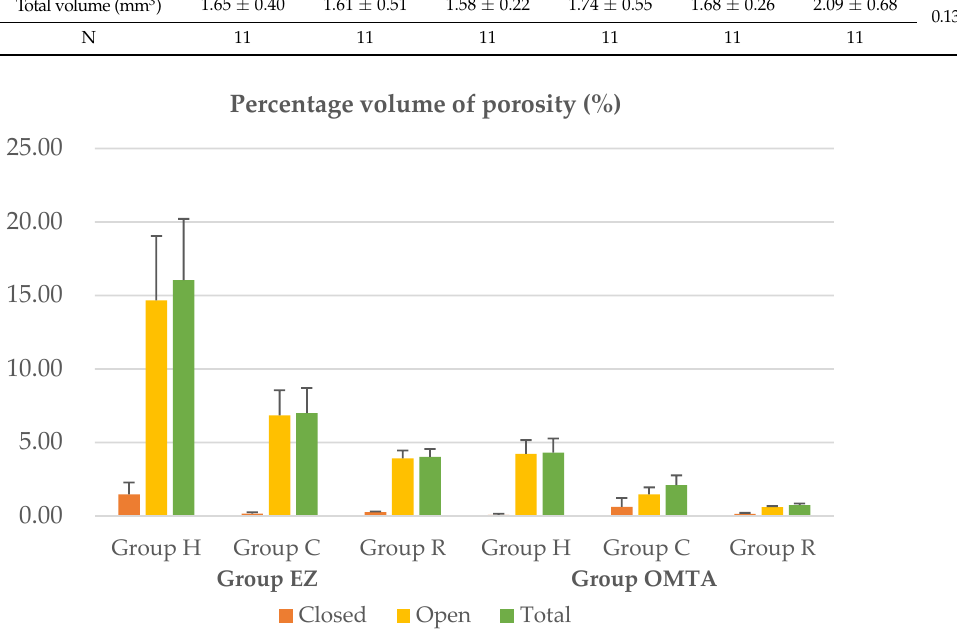
Representative 3D images illustrated the presence and distribution of voids within the root canal fillings, showing more open porosity (green) than closed porosity (red) in